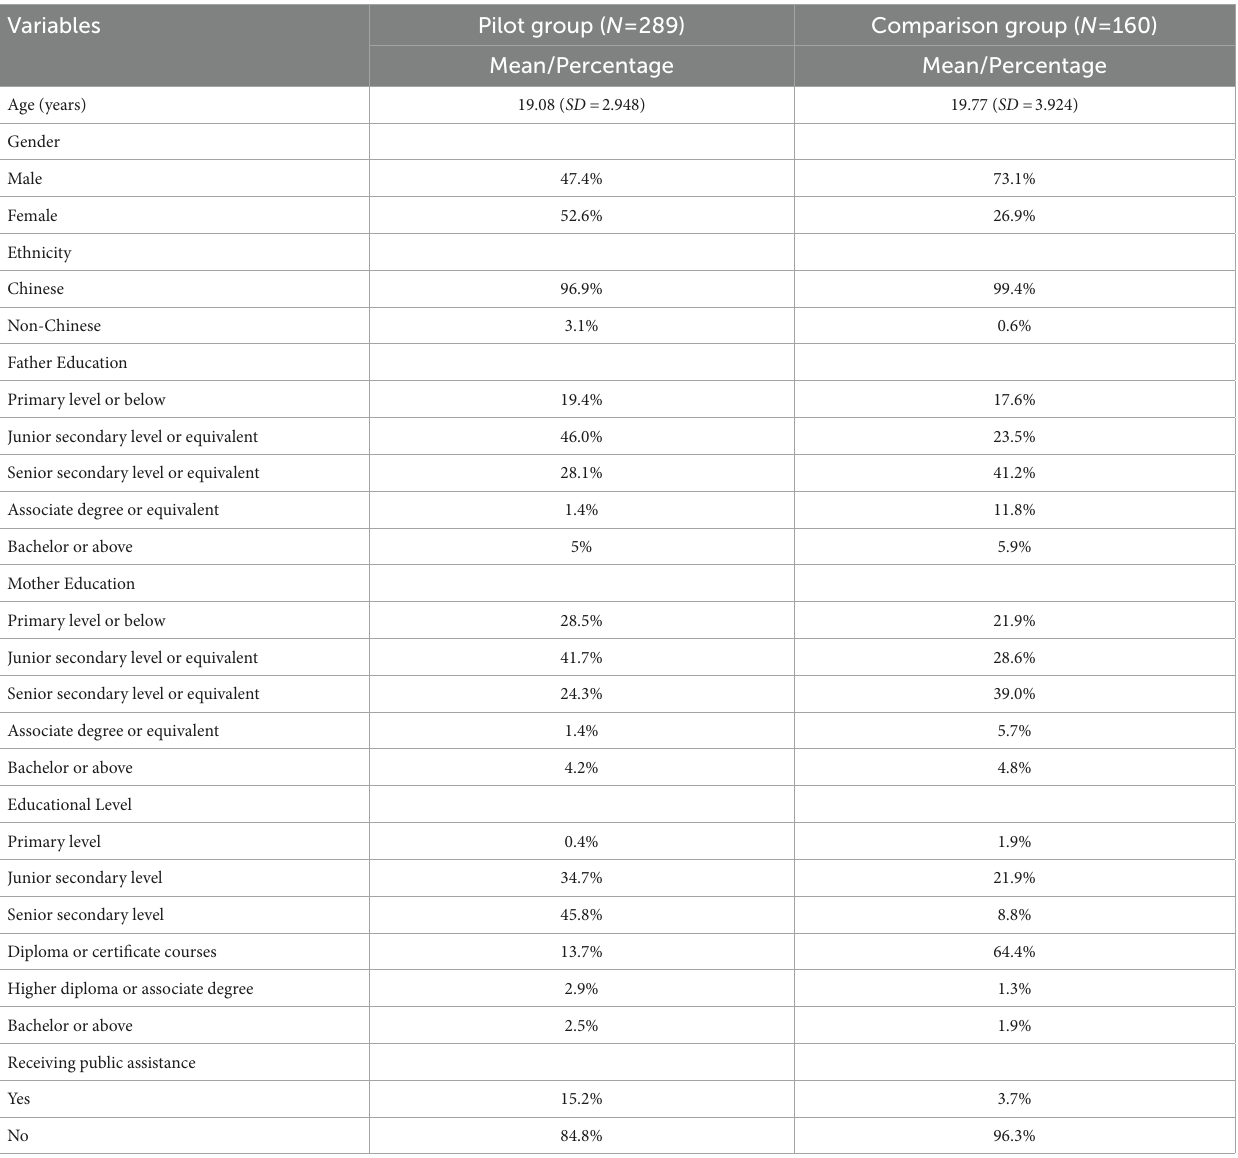
TABLE 1 Profile of Participants in the Quantitative